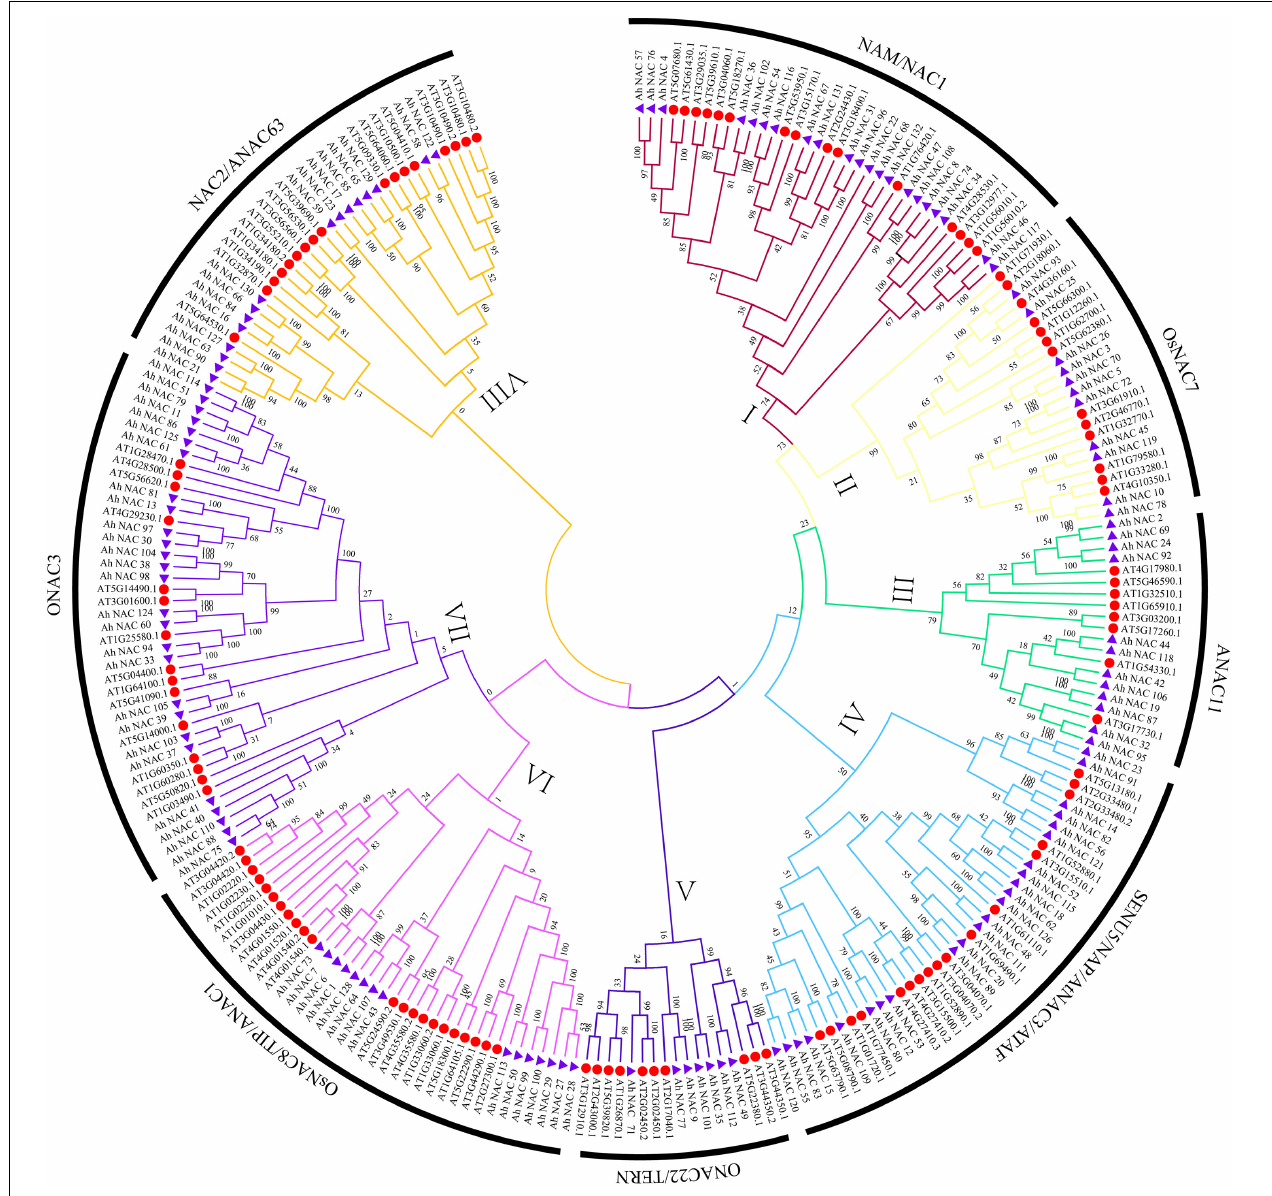
FIGURE 1 | An unrooted phylogenetic tree representing the relationships among the NAC proteins of peanut and Arabidopsis . All full-length protein sequences were aligned by MUSCLE, and the tree was generated using the neighbor-joining (NJ) method in MEGA7 software. The I–VIII subgroups are represented by different colors, the purple triangles represent NAC proteins from peanut, and the red circles indicate the Arabidopsis